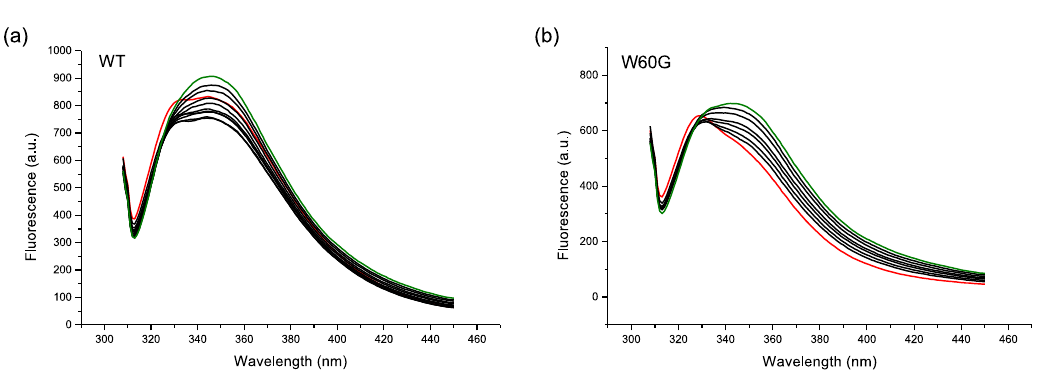
Figure 7. ( a , b ) Fluorescence quenching of 0.5 µ M wild-type (WT) and W60G β 2m, respectively, with MPA-AuNP concentrations ranging from 0 to 50 nM. The control sample spectrum is shown in red, while the last titration point in green. Each titration point corresponds to a NP increase of 5 or 7 nM, approximately, for the experiments done with WT or W60G, respectively. For WT, the first two additions caused an intensity decrease and the following ones a progressive increase. For W60G, all the consecutive additions led to progressive intensity increase.